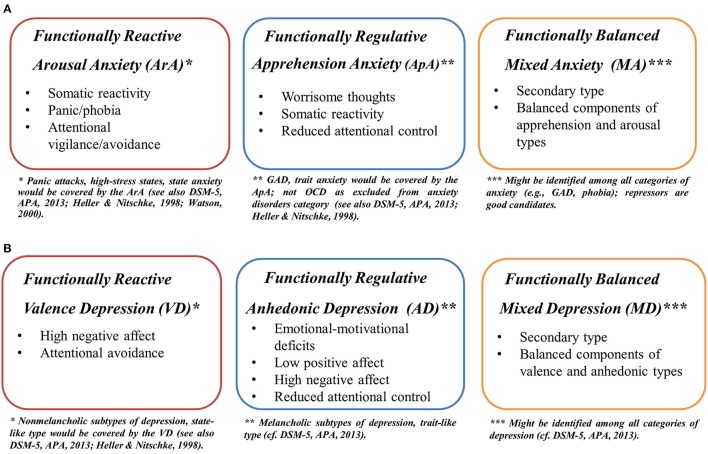
Operationalization of (A) anxiety types, (B) depression types (cf. Fajkowska, 2013, 2015).